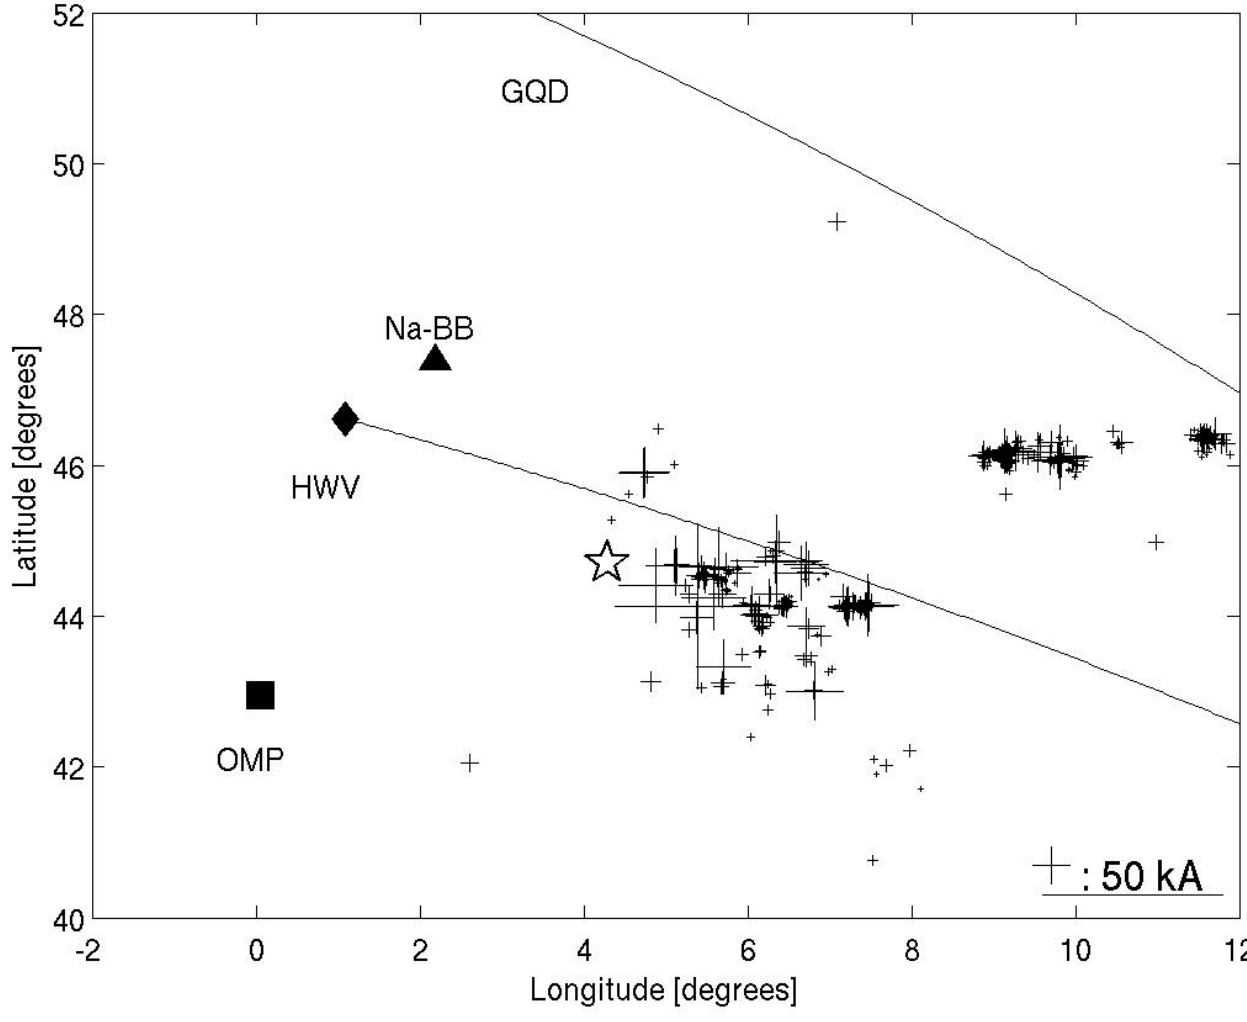
Fig. 1. Locations of CG discharges (crosses) observed within a ± 5min interval around the elve occurrences during the night of 23–24 July 2003. The sizes of the crosses are scaled with the peak current intensities. The star marks the location of an elve, estimated by other methods, for which lightning data was unavailable (discussed in chapter 3.1). The locations of the Pic du Midi Observatory and the Nanc¸ay broadband VLF receiver are also shown along with the GCPs of the transmitter signals to Crete on which early VLF perturbations were